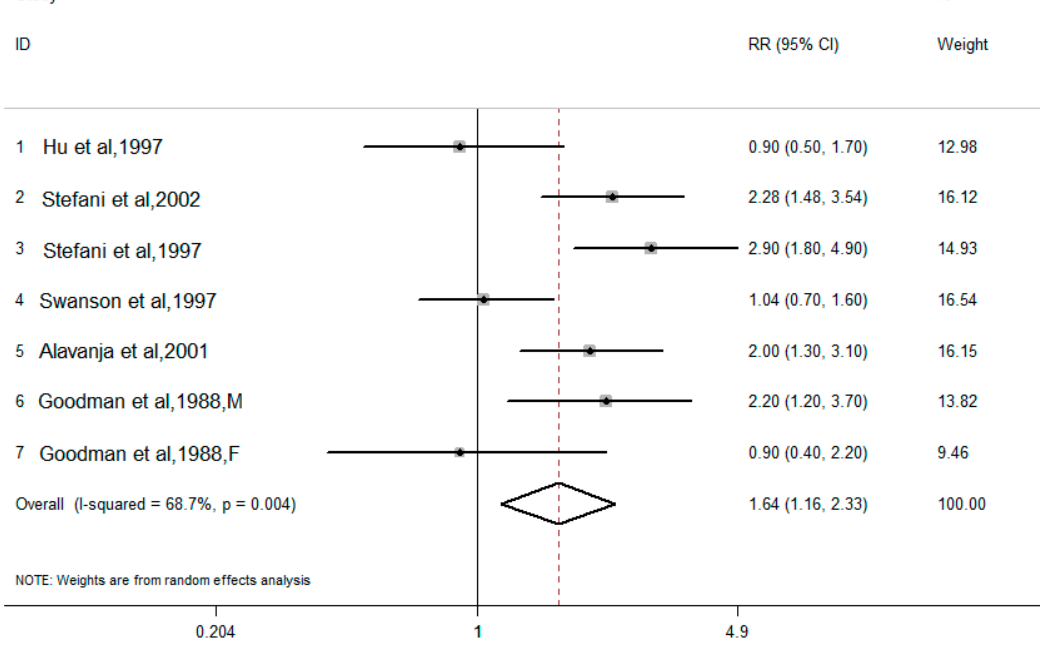
Figure 4. Forest plot of the highest compared with the lowest categories of intake of dietary total fat and lung cancer risk in six case-control studies.